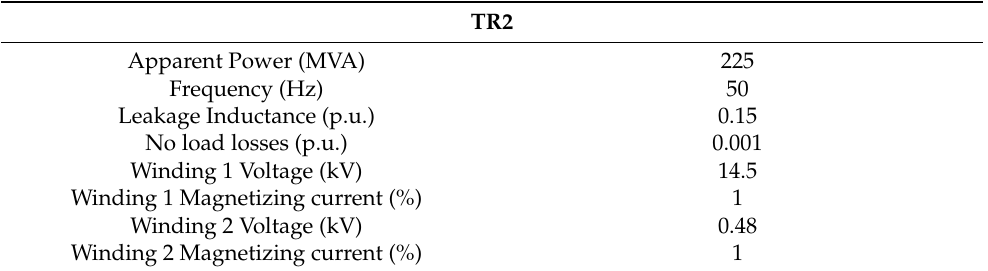
Table 5. TR2 transformer data.